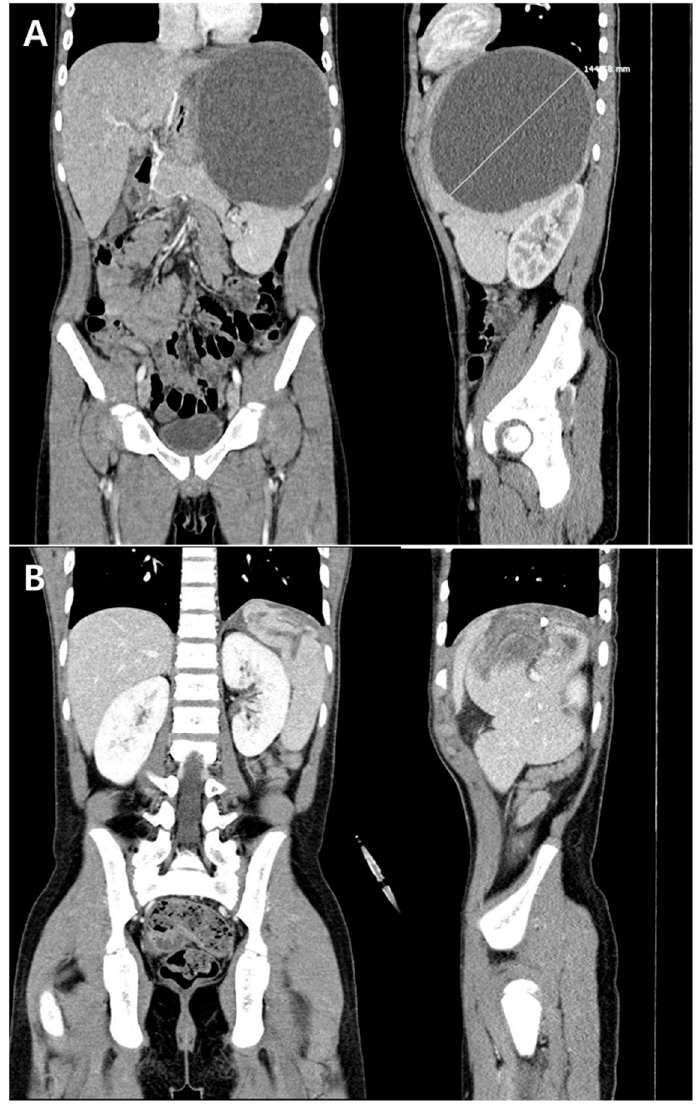
Figure 1. Abdominal computed tomography shows a large abscess with a maximum diameter of 14.5 cm on admission ( A ), and the abscess decreased in size on hospital day (HD) #11 ( B ). Intravenous metronidazole (40 mg/kg/day) was added to the cefotaxime therapy for possible amoebic abscess. On the second hospital day (HD #2), US-guided percutaneous drainage of the